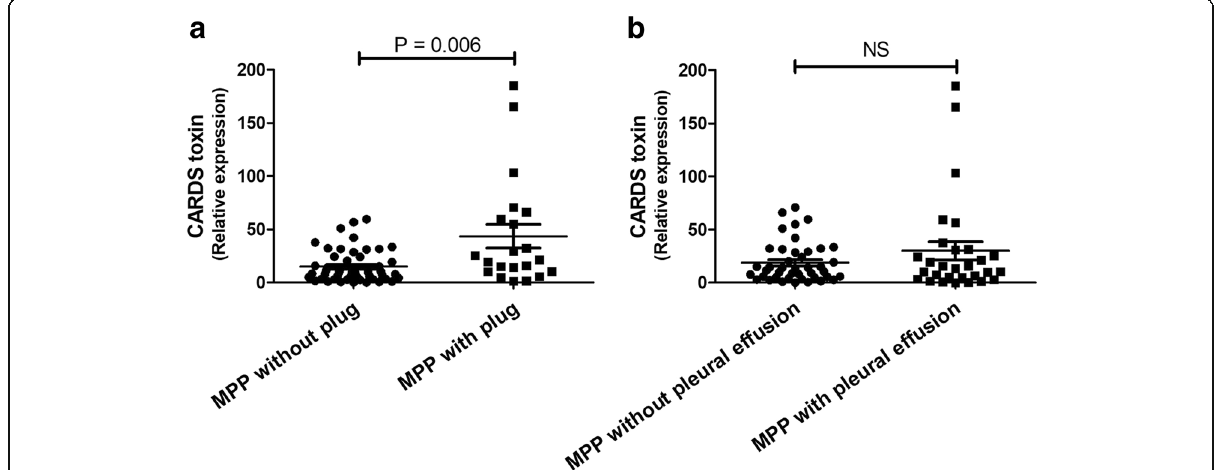
Fig. 1 Comparison of CARDS toxin expression between MPP cases with/without plug ( a ) and pleural effusion ( b ). Children with MPP were divided into MPP with plug group ( N =50) and MPP without plug group ( N =21), according to the presence or absence of mucus plugs. They were also divided into MPP with pleural effusion group ( N =42) and MPP without pleural effusion ( N =29) group, according to results of imageological examination. The expression of CARDS toxin in bronchoalveolar lavage fluid (BALF) in each group was measured. NS, no